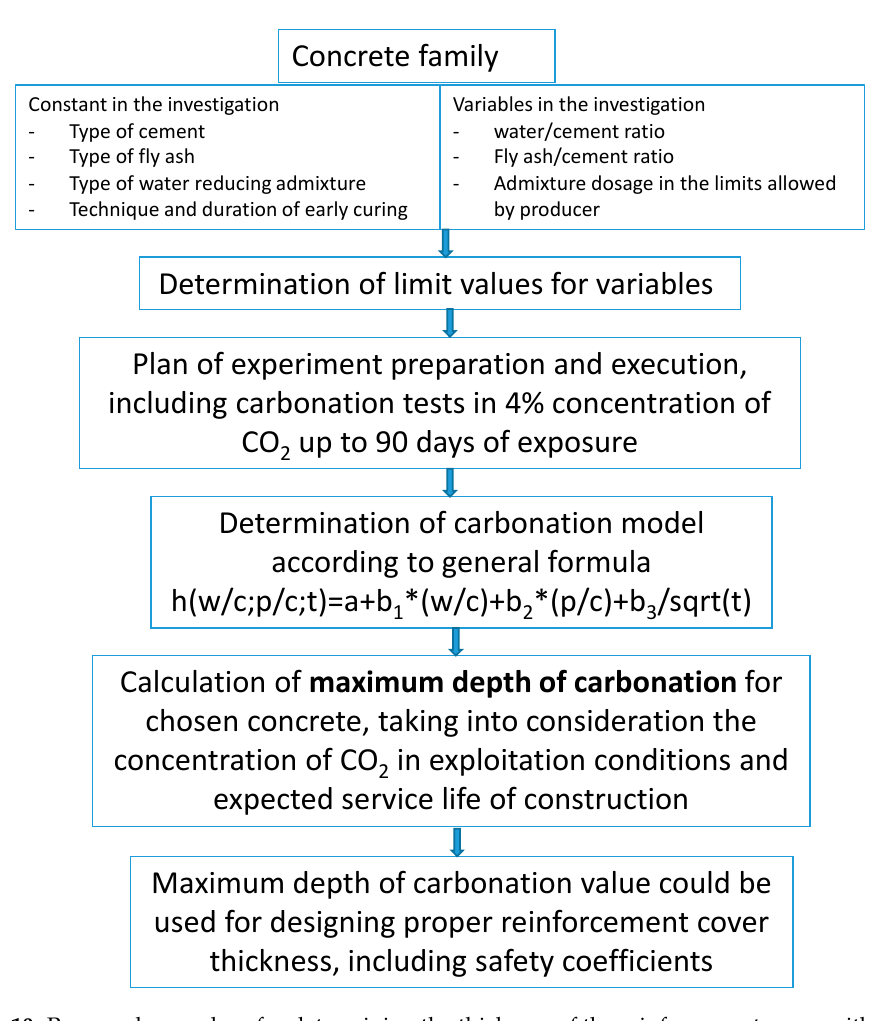
Figure 10. Proposed procedure for determining the thickness of the reinforcement cover with use of the developed model of carbonation.